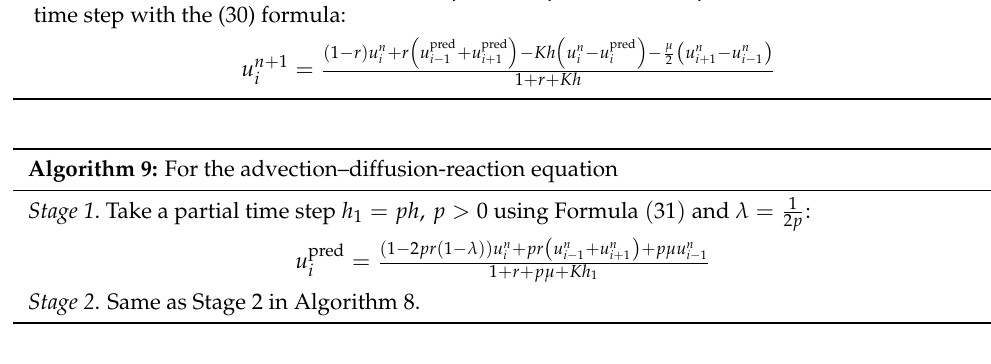
Algorithm 10: For the advection–diffusion-reaction equation Stage 1 . Same as Stage 1 in Algorithm 8.